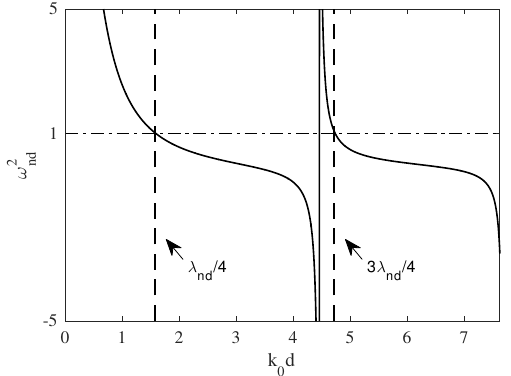
Figure 9. Dimensionless frequency vs. dimensionless chamber length. Solid line, ω nd ; vertical dashed lines, λ nd /4 and 3 λ nd